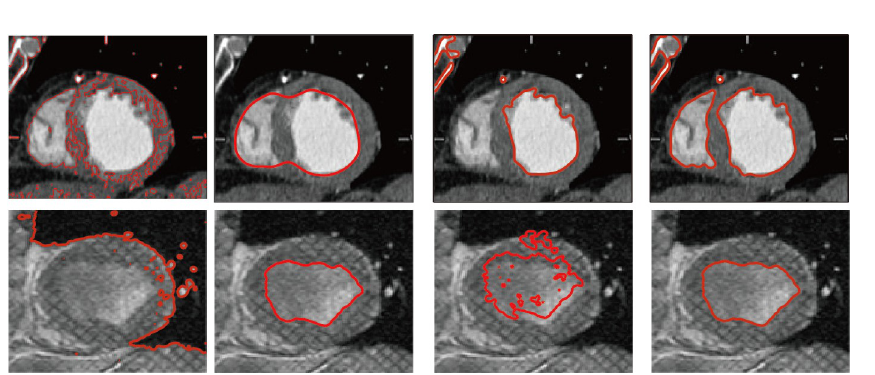
Fig 4. Comparisons of the proposed model with the CV, the LVC, the LRFI on heart images.